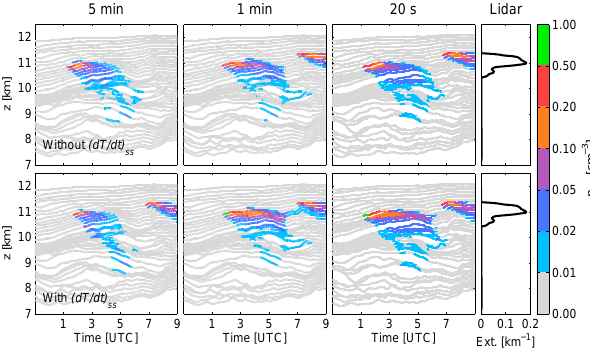
Figure 7. Same as Fig. 6 but for the ice crystal number density n ice in cm − 3 (colour